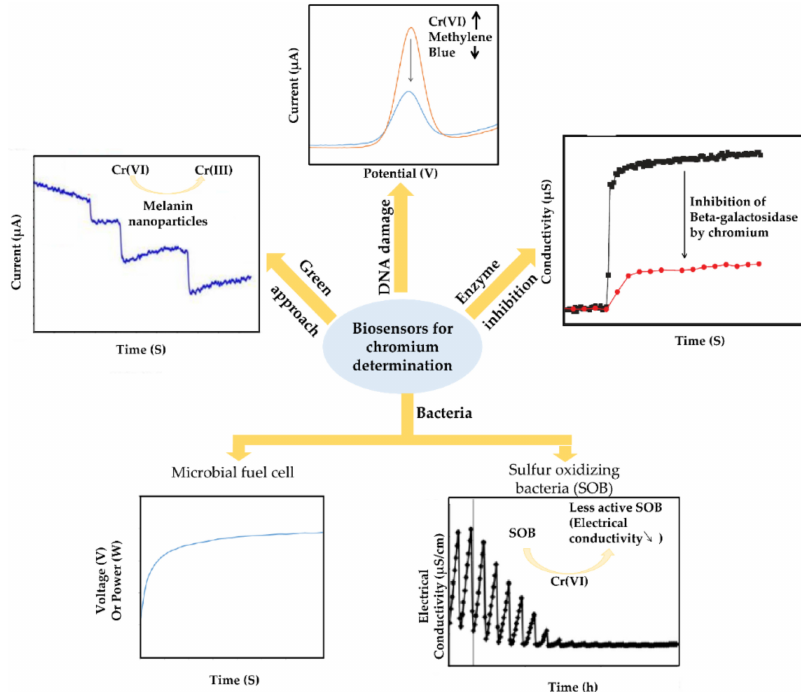
Figure 4. Scheme of di ff erent used biosensors for chromium